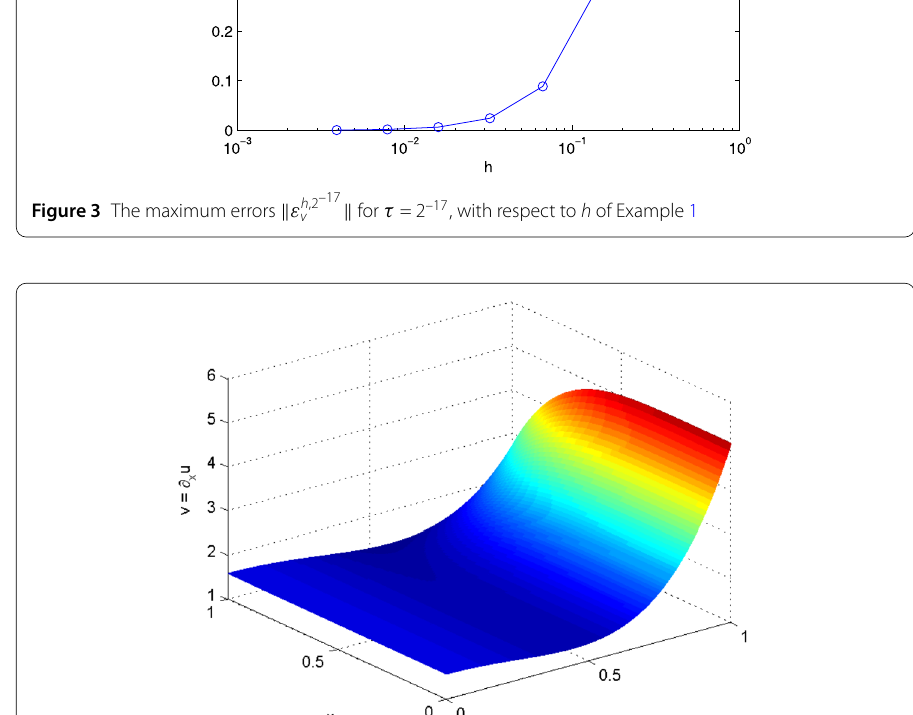
Figure 4 The function v presenting the exact solution ∂ x u for Example 1